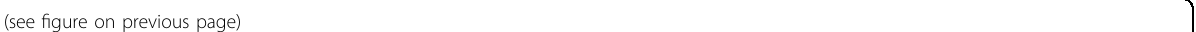
Fig. 6 ER-phagy could promote Ca2 + release so as to induce Syt7 mediated lysosomal exocytosis and metastasis in 786O/OE-SR cells. a CCK8 showed the viability of 786 O cells or transfected with Syt7, Syt7 Δ tC2AB with increasing concentration of sunitinib. Data were obtained from three independent experiments. b CCK8 showed the viability of 786 O/OE-SR cells or Syt7 knockdown 786 O/E-SR cells with increasing concentration of sunitinib. Data were obtained from three independent experiments. c Transwell assay showed that knockdown of Syt7 could reverse the effect of TFE3 on tumor metastasis in 786 O/OE-SR cells in the condition of sunitinib (10 µM). Scale bar, 200 μ m *** P < 0.001, ** P < 0.01, * P < 0.05. Data were obtained from three independent experiments. d Confocal images of vesicle exocytosis. 786 O/OE-SR cells transfected with mCherry-Syt7 or mCherry-Syt7 Δ tC2AB were incubated with ionomycin (2 µM) 2 h. White arrows indicate lysosome. Scale bar 20 µm. e 786 O/OE-SR cells transfected with FAM134B were treated with or without CA-074Me, sh-CTSB. Cells were incubated with 2 µm Fluo-3-AM at for 30 min and then fl ow cytometry was used to test the relative Ca2 + concentration. The results represent the mean ± SD. ** P < 0.01, NS: not signi fi cant. Data were obtained from three independent experiments. f 786 O/OE-SR cells with or without E-Syt1 knockdown were transfected with indicated plasmids of Syt7 mutants. Cells were incubated with 2 µM Fluo-3-AM for 30 min and then fl ow cytometry was used to test the relative Ca2 + concentration. Results represent the mean ± SD. * P < 0.05, ** P < 0.01, *** P < 0.001, NS: not signi fi cant. Data were obtained from three independent experiments. g Confocal images of vesicle exocytosis. 786 O/OE-SR cells stably expressing mCherry-Syt7 were treated with DMSO or sunitinib (10 µM) for 12 h and were transfected with sh-Esyt1 or sh-NC. White arrows indicate lysosome. Scale bar 20 µm. h 786 O/OE-SR cells transfected with or without FAM134B-vector were incubated with sunitinib (10 µM) or DMSO for 12 h, WB tested ER stress-related markers. i Representative lungs and corresponding H&E sections from different cohorts were shown. mice injected with Syt7 knockdown 786 O/OE-SR cells showed signi fi cantly reduced metastasis incidence in the condition of